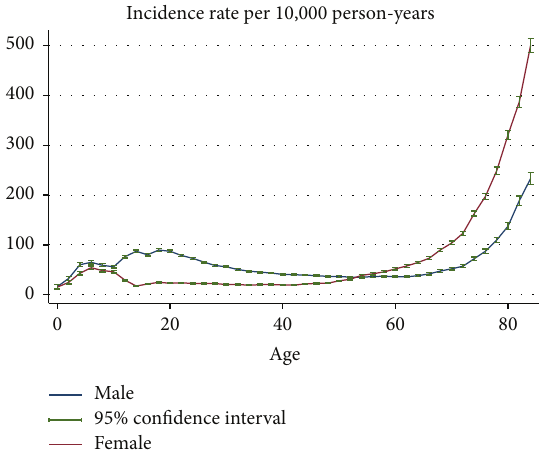
Figure 2: Gender-age-specific incidence rates of fracture hospitali- sation for the age between 18 and 50 years.